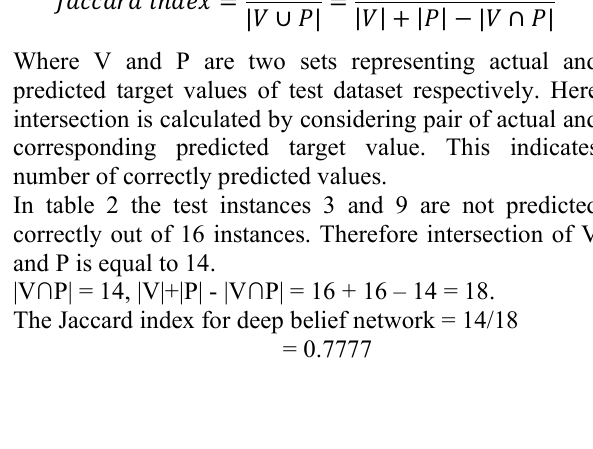
Table 2. Actual and predicted target values of test dataset for deep belief network.